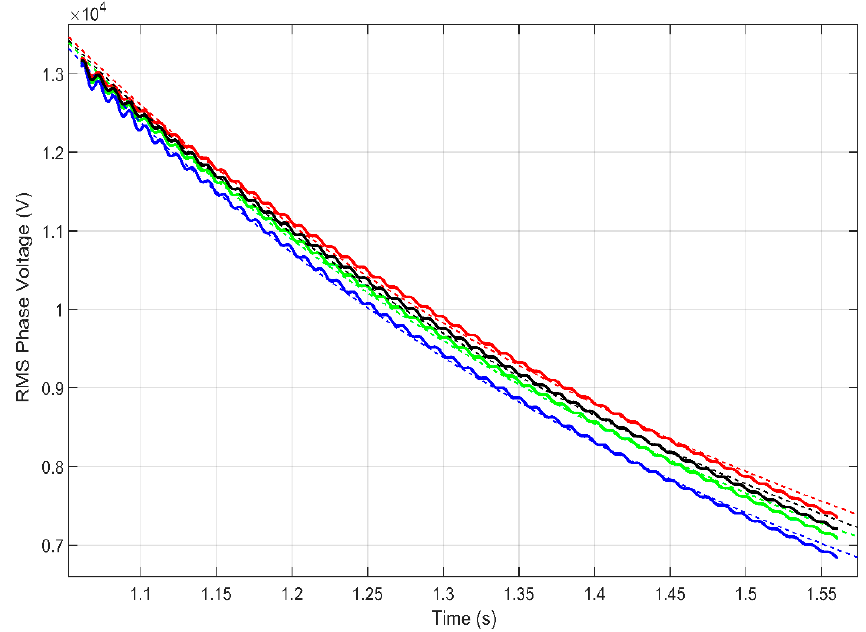
ff erent feeder-load values.